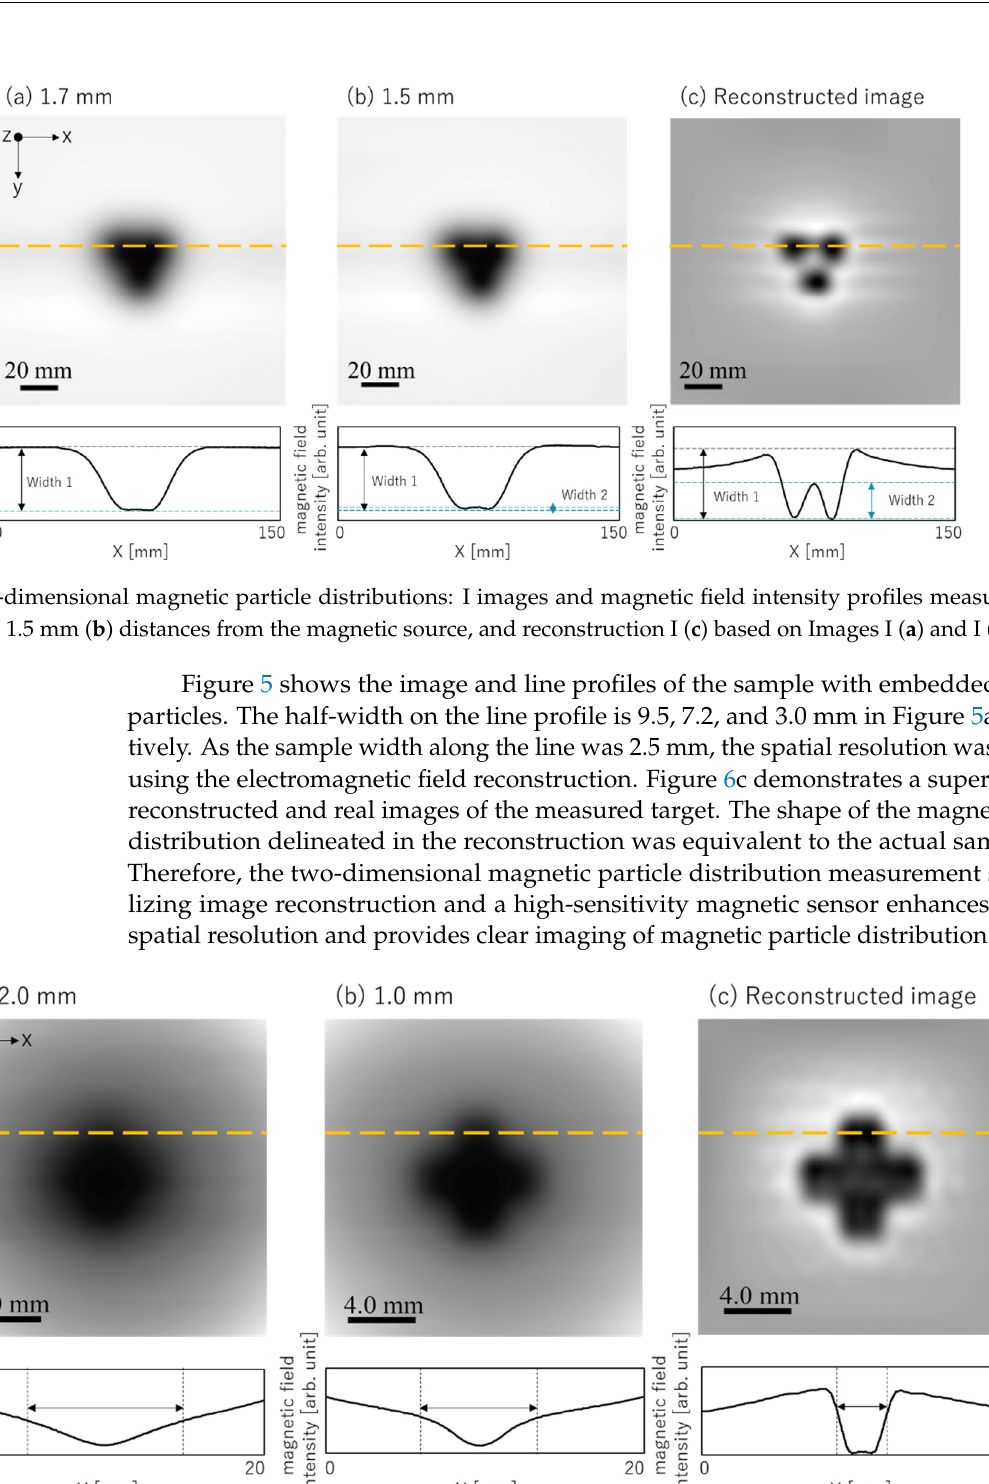
Figure 5. Two-dimensional magnetic particle distributions: I images and magnetic field intensity profiles measured at 2.0 mm ( a ) and 1.0 mm ( b ) from the magnetic source, and reconstruction I ( c ) based on Images I ( a ) and I ( b ).